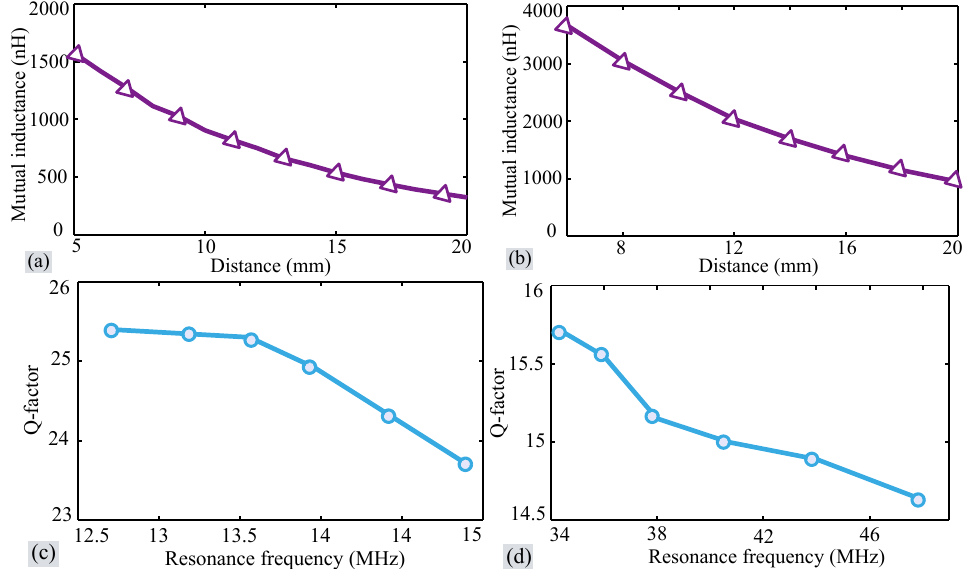
Figure 4. ( a ) Mutual inductance vs. distance between the coils at 13.56 MHz; ( b ) Mutual inductance vs. distance between the coils at 40.68 MHz; Q-factor vs. resonance frequency at ( c ) 13.56 MHz operating frequency; ( d ) 40.68 MHz operating